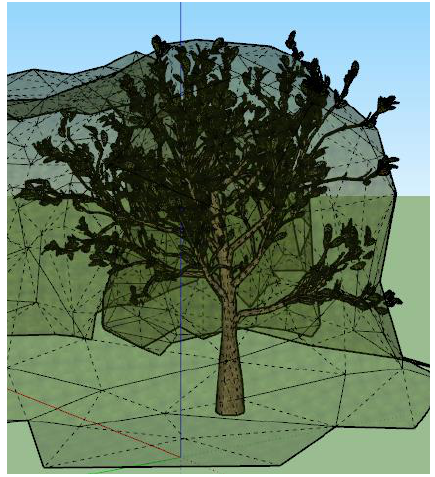
Figure 7. 3D tree model within the tree